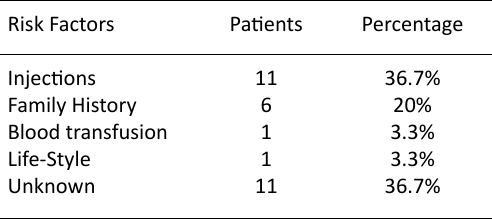
table 1. Analysis of Risk Factors Risk Factors